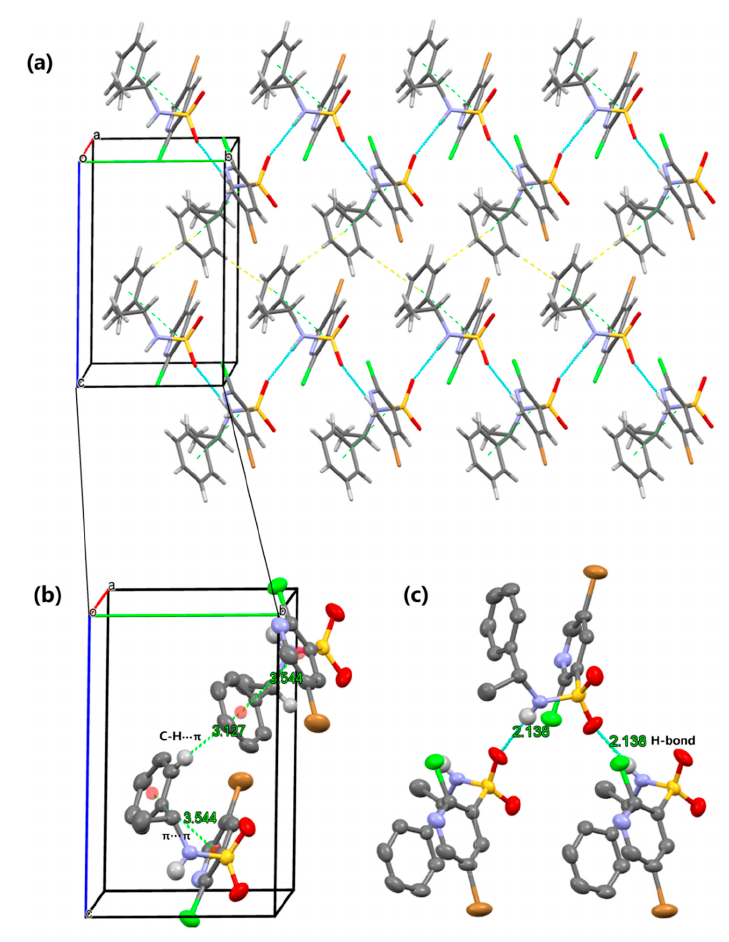
Figure 5. Crystal packing showing intermolecular N–H···O hydrogen bond, C—H··· π and π - π interactions of 10a as dashed lines. Table 2. Gibbs free energies (G), relative Gibbs free energies ( △ G) a and Boltzmann weighting factor ( P %) b of 10a and 10b conformers by using the DFT/B3LYP/6-311++G(2d, p) method.